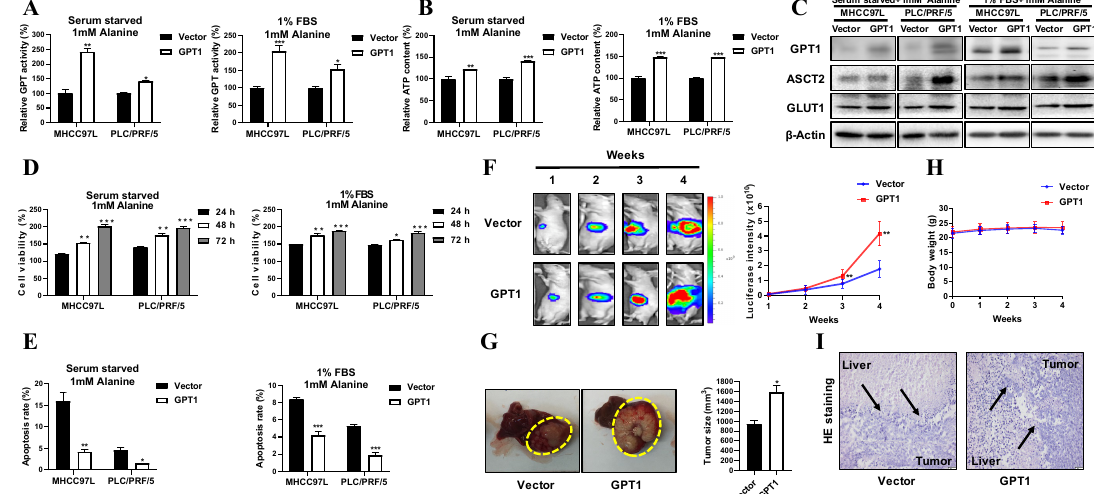
Figure 2. Overexpression of GPT1 in the activated glucose–alanine cycle promoted HCC growth. ( A ) The GPT activity levels of MHCC97L and PLC / PRF / 5 cells with or without stable GPT1 overexpression under alanine-rich conditions for 24 h. ( B ) The ATP content levels of MHCC97L and PLC / PRF / 5 cells with or without stable GPT1 overexpression under alanine-rich conditions for 24 h. ( C ) The representative Western blot panels of GPT1, ASCT2, and GLUT1 protein levels in MHCC97L and PLC / PRF / 5 cells with or without stable GPT1 overexpression under alanine-rich conditions for 24 h. ( D ) The cell viability analysis of MHCC97L and PLC / PRF / 5 cells with or without stable GPT1 overexpression under alanine-rich conditions for 24, 48, and 72 h. ( E ) The cell apoptosis analysis of MHCC97L and PLC / PRF / 5 cells with or without stable GPT1 overexpression under alanine-rich conditions for 24 h. ( F ) The representative images and statistical graph of tumor growth with or without stable GPT1 overexpression based on luciferase signals during the experiment ( n = 5). ( G ) The representative images and statistical graph of tumor size with or without stable GPT1 overexpression at the end of the experiment ( n = 5). ( H ) The statistical graph of body weight of tumor-bearing mice with or without stable GPT1 overexpression during the experiment ( n = 5). ( I ) The representative H&E staining images of the boundary of tumor and liver tissues with or without stable GPT1 overexpression at the end of the experiment ( n = 5). All experiments were conducted in triplicate unless otherwise stated. * P < 0.05, ** P < 0.01, *** P <